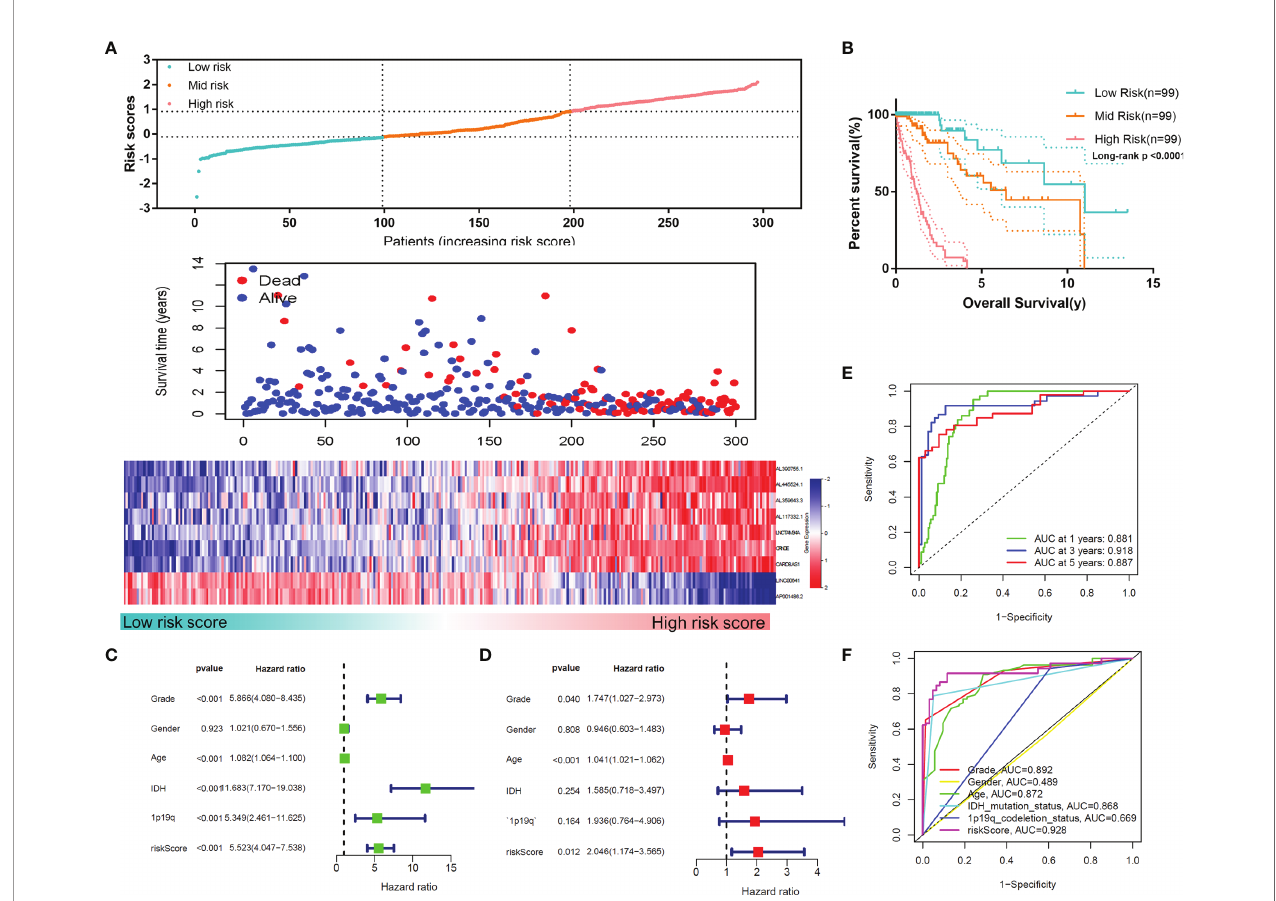
FIGURE 5 | (A) The distributions of risk scores, alive/dead status and the expression of nine m6A-related lncRNAs in the training set. (B) Overall survival analysis for patients in the high- and mid-/low-risk groups. (C) Univariate and (D) multivariate Cox regression analyses for OS in glioma patients in the training set. (E) ROC curve of the risk score at different follow-up times. (F) The ROC curve of the risk score and other clinical